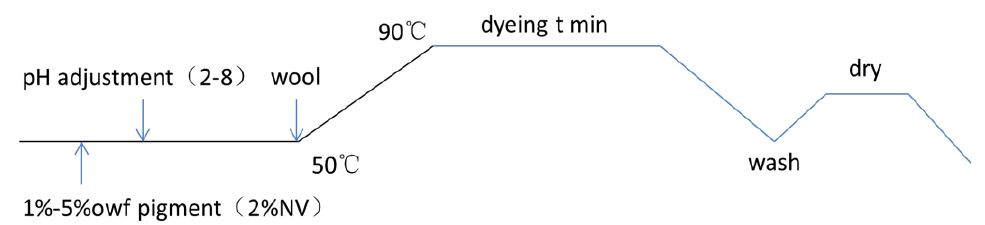
Figure 2. Dyeing process for wool with self-dispersing pigment.